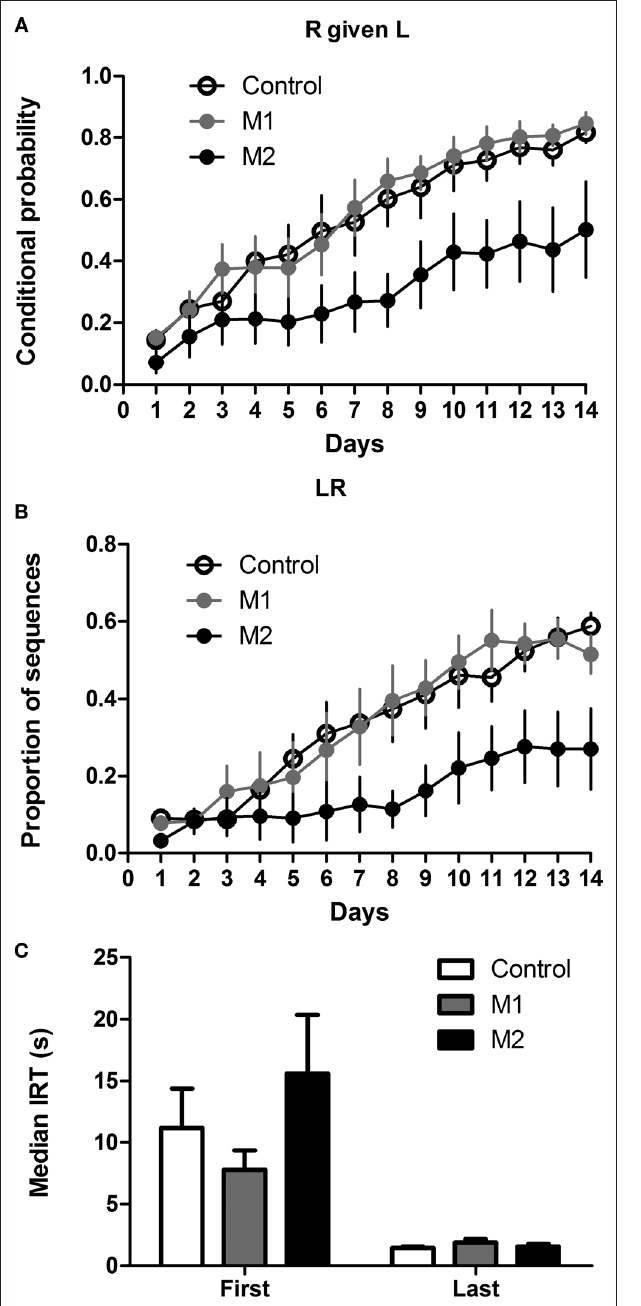
FIgure 7 | reversal of serial order from left-right to right-left. (A) Conditional probability of left press given right press. (B) Proportion of right → left sequences expressed as percentage of the RL proportion on the last day of training for the previous left → right sequence. (C) Inter-response-times (IRT) of correct sequences on the first and last days of